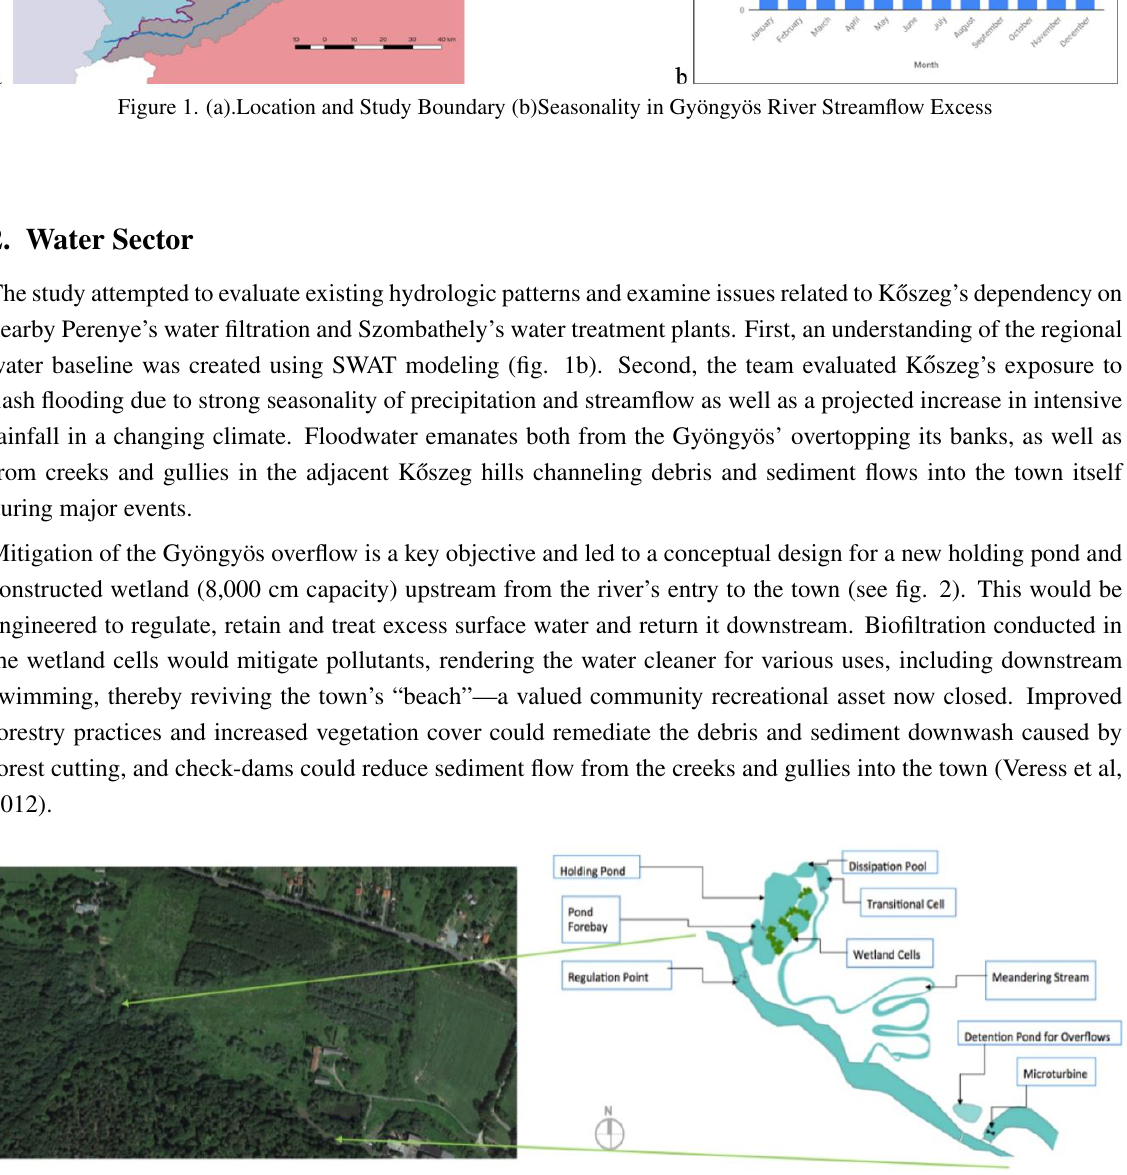
Figure 2. Gy ¨ ongy ¨ os Proposed Wetland: Aerial view (Google Earth) and Conceptual